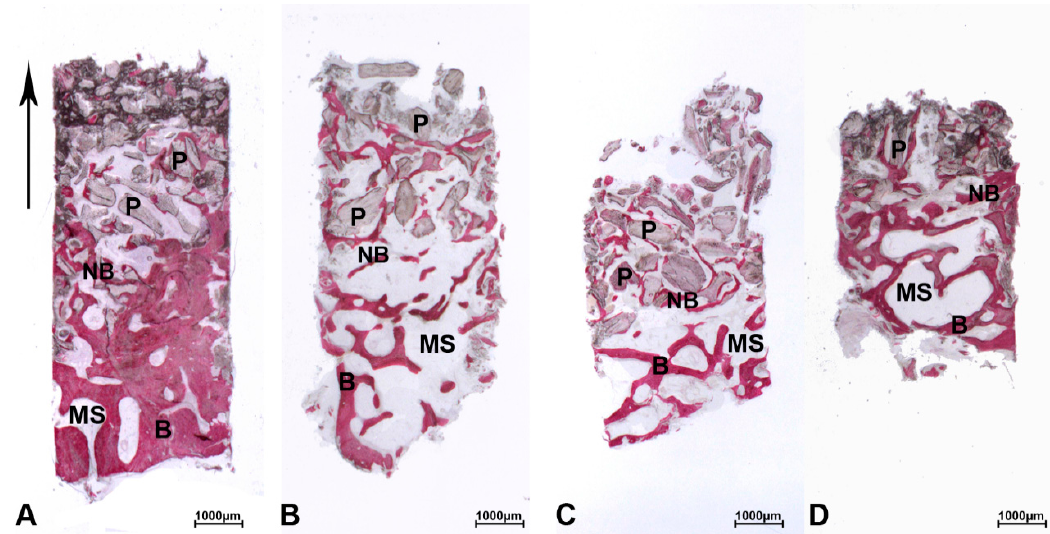
Figure 1. Deproteinized equine bone mineral (DEBM). The biopsies were oriented in the crestal-apical direction ( ↑ ) and all biopsies showed a small portion of the pre-existing bone (B) with large marrow spaces (MS). ( A ) In the crestal portion, pre-existing bone (B) with small marrow spaces (MS) and new bone (NB) were present, whilst in the middle portion, the biomaterial particles (P) were gathered but distant and tended to merge in the apical portion. New bone formation (NB) was more present around the particles (P) near the pre-existing bone (B) and less present far from them. ( B ) In the crestal portion, pre-existing bone (B) with large marrow spaces (MS) and new bone (NB) were observed. In the middle portion, the biopsy showed the presence of trabecular bone with large marrow spaces and residual biomaterial (P) which exhibited different sizes in the apical portion. New bone formation (NB) was more present around the particles near the pre-existing bone (B) and less present far from them. ( C ) This biopsy was partially damaged during their removal from the trephine. In the crestal portion, trabecular bone (B) with large marrow spaces (MS) and new bone (NB) were detected. The residual grafted particles (P) were partially encircled by newly formed bone (NB). ( D ) In the crestal portion, the biopsy showed a small portion of pre-existing bone (B) with large marrow spaces (MS) and new bone (NB). Thin trabeculae, wide marrow spaces, and residual DEBM particles scattered in the weave of newly formed bone were present in the apical portion of the sample. Most of the biomaterial granules (P) were partially encircled by new bone (NB). (Toluidine blue and acid fuchsin, original magnification (6 × )). The particles located next to the pre-existing bone of the crestal region were totally or partially encircled by newly formed bone which showed wide osteocyte lacunae, typical of recently mineralized bone (Figure